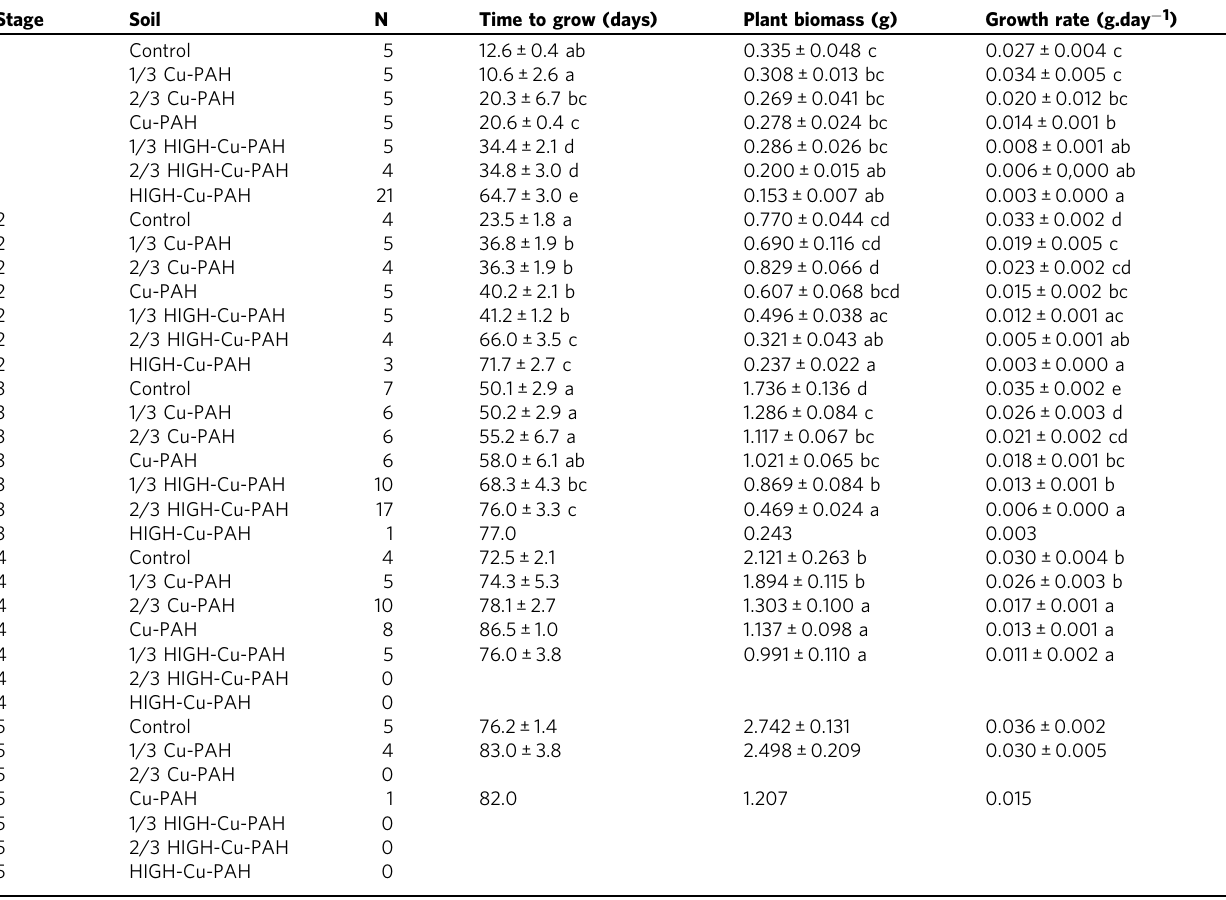
Table 1 Growth performance of Phaseolus vulgaris plants across the soil series, and at different development stages.